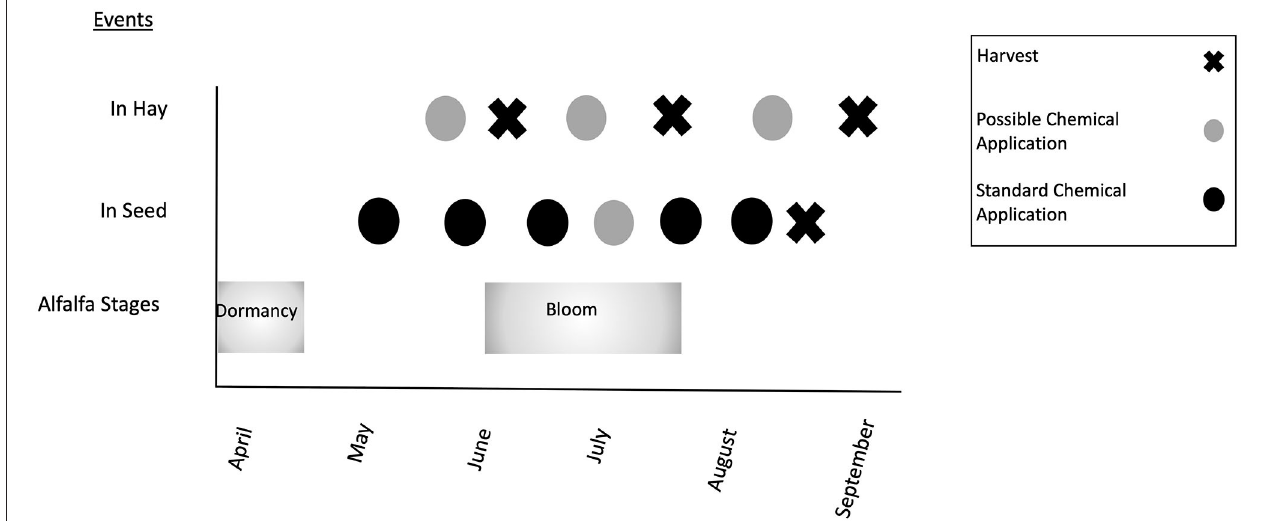
FIGURE 1 | Comparison of typical management practices in alfalfa hay and seed